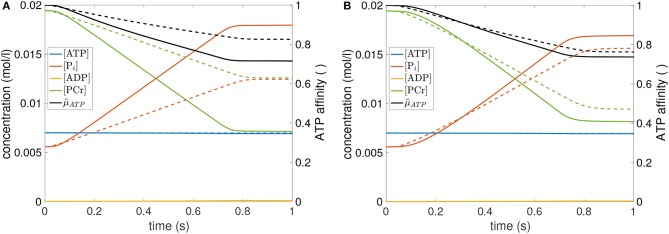
Time courses of [ATP], [Pi], [ADP], and [PCr] (left ordinate) as well as μ~ATP (right ordinate) for GAS (A) and PLA (B). Solid lines represent the time courses for the shortest muscle examined in our experiments (cf. Figure
1). Dashed lines represent the respective longest muscle. Time courses for [Cr] are not shown due to a near congruence with [Pi](t). Note that the ATP affinity decreases substantially, due to increasing Pi, while the [ATP] itself remains almost constant.